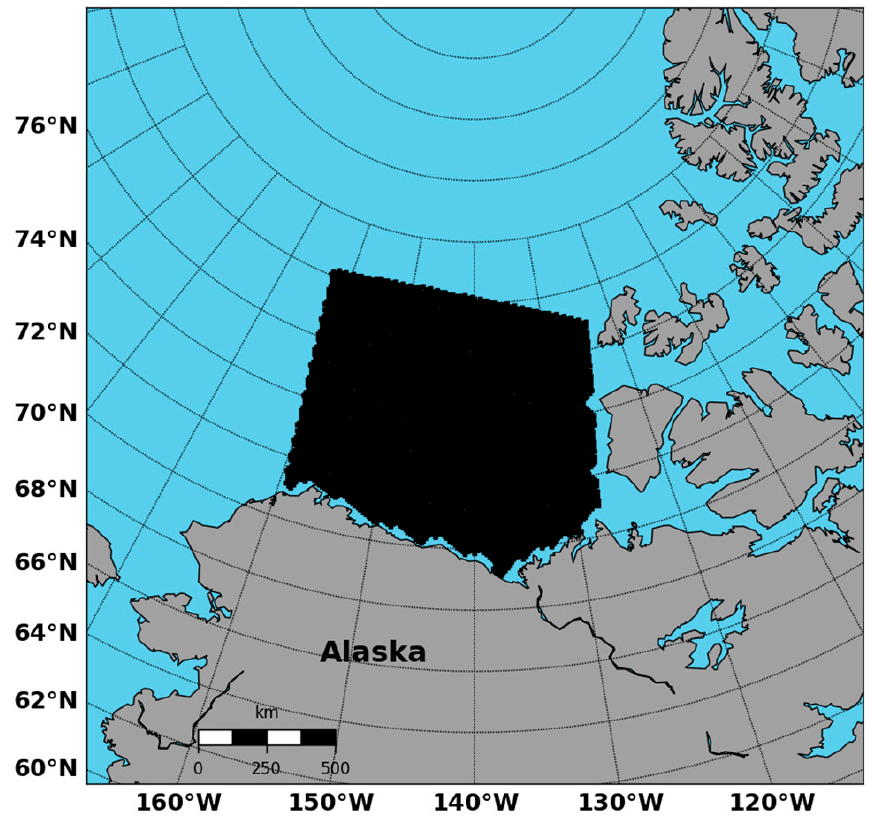
Figure 1. Beaufort Sea Study Region Shaded in